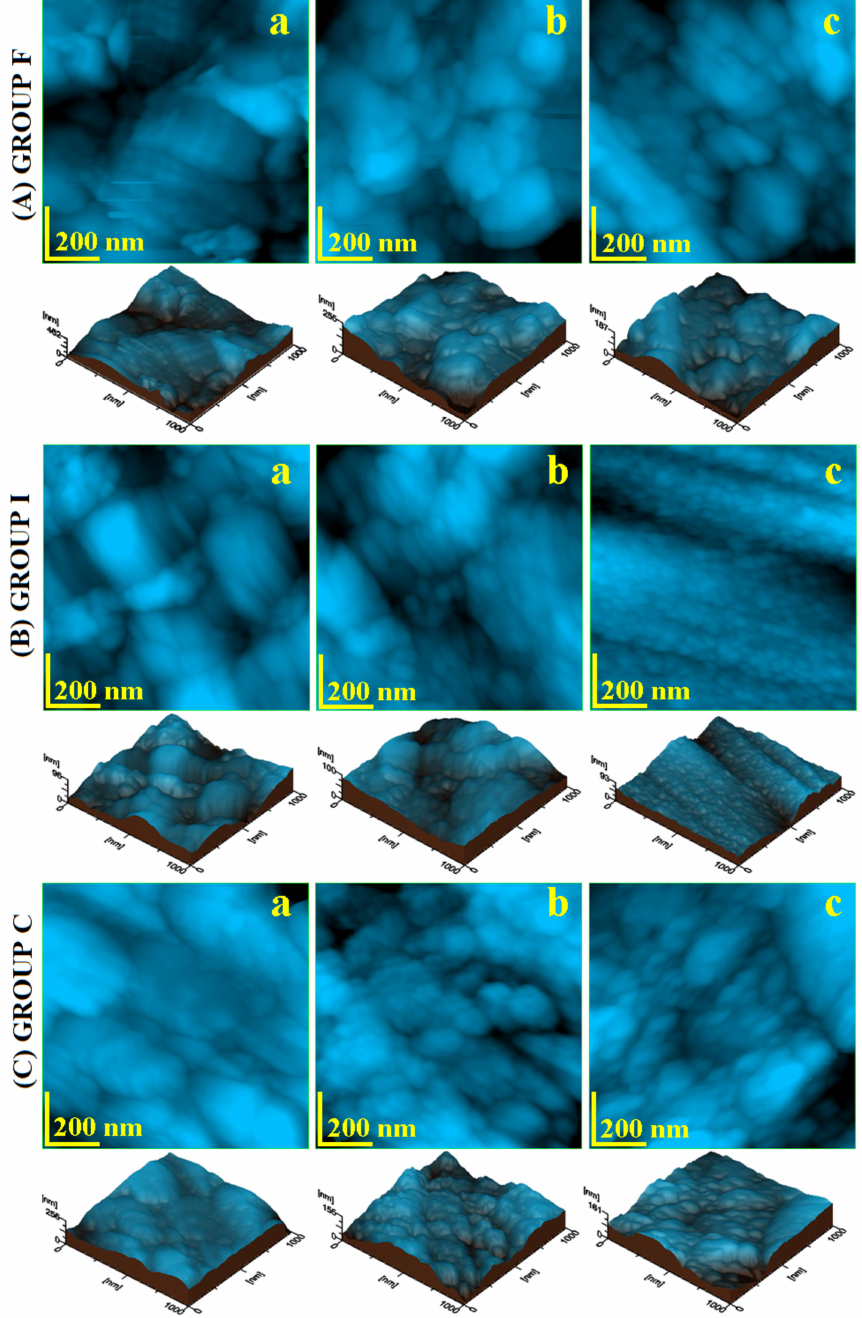
Figure 4. AFM topographic images of the nanostructure without treatment ( a ), after fluorination ( b ), and after photodynamic laser fluorination ( c ), for the investigated samples. The tridimensional profile is given below each topographic